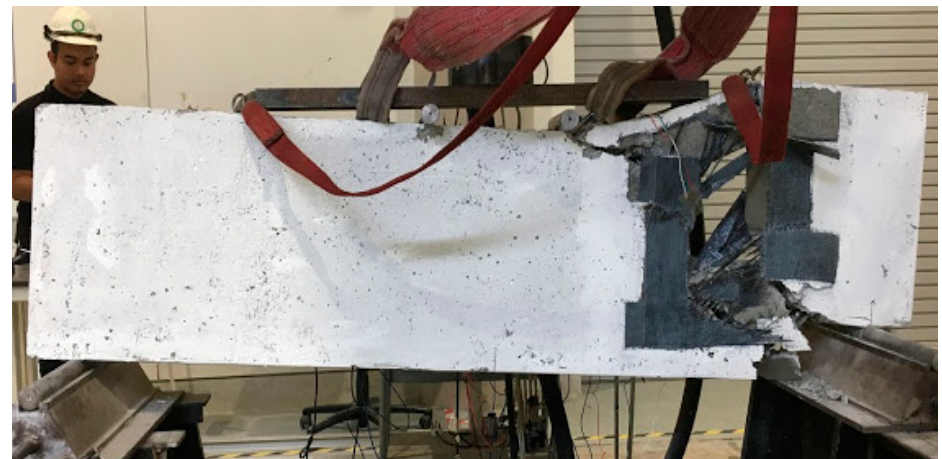
Figure 9. Failure mode and cracking pattern of deep beam B2a.